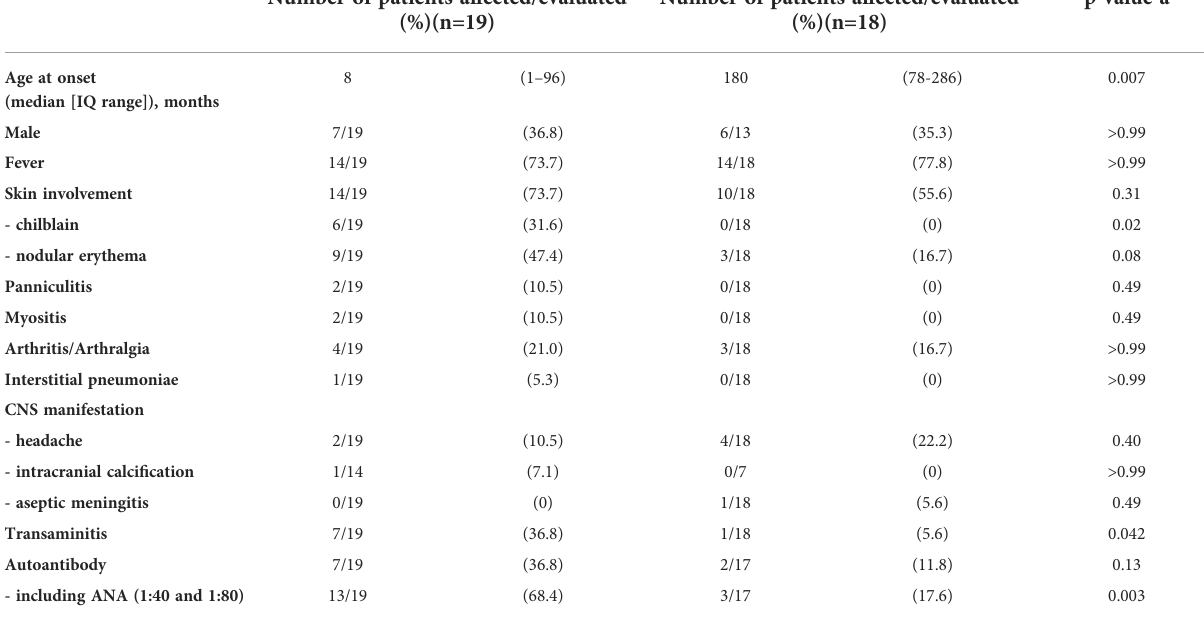
TABLE 1 Comparison of clinical phenotypes in patients with and without enhanced IFN signaling. Patients with high IS Patients without high IS Number of patients affected/evaluated Number of patients (%)(n=19)